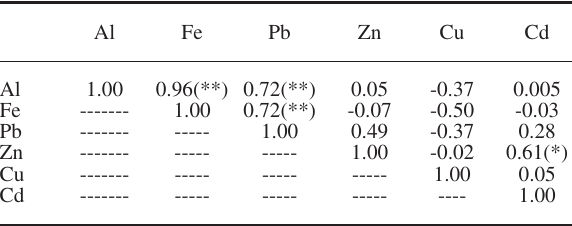
Table 4. – relationships (measured by spearman rank correlation) between metals in surface sediments (top 5 cm) of central sado estuary.